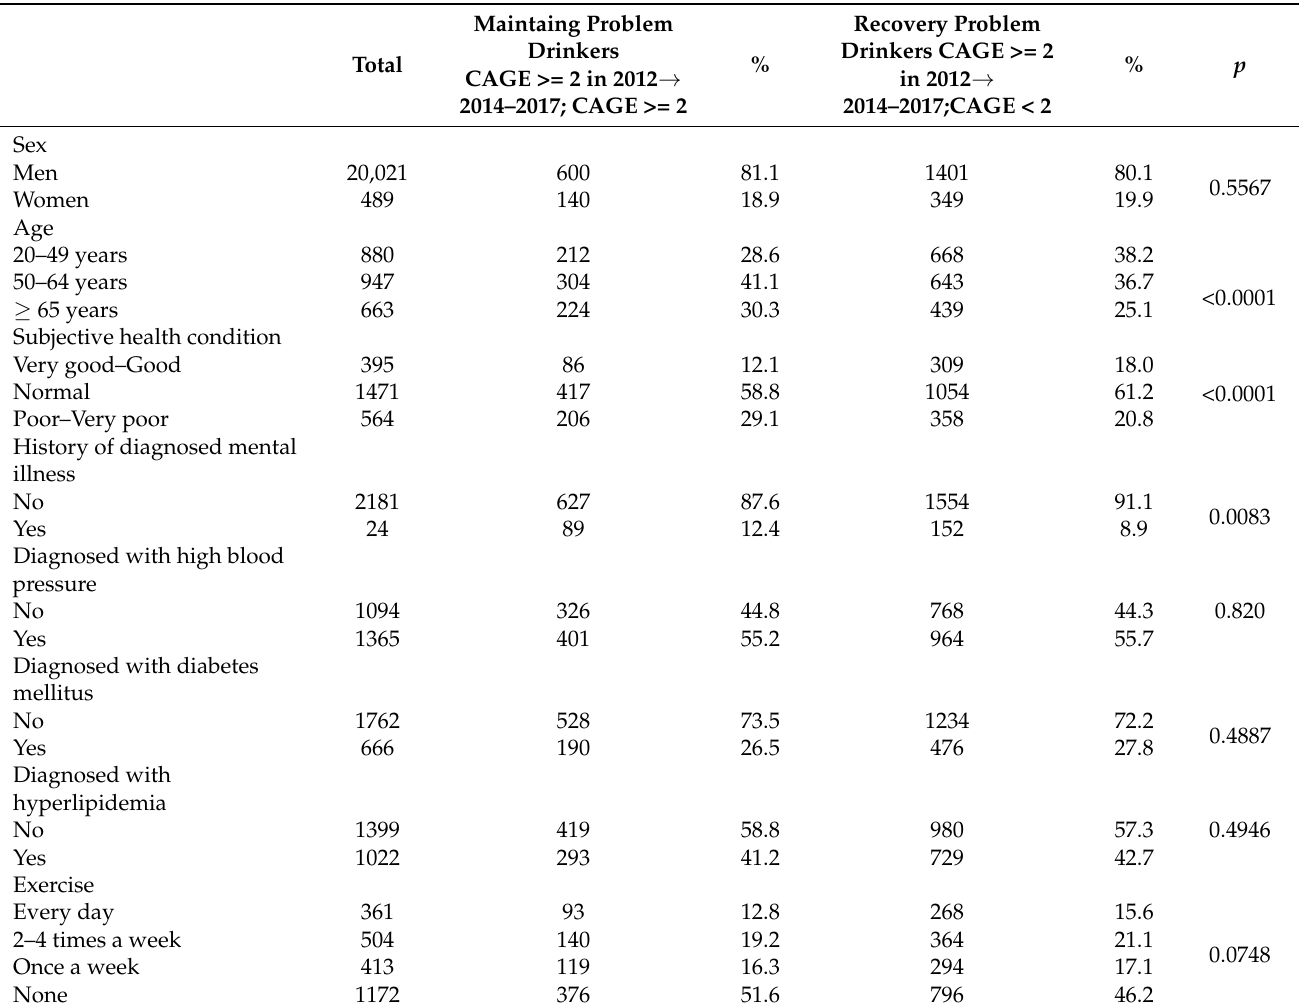
Table A4. Characteristics of problem drinkers in FY 2012 by subsequent recovery excluded in FY